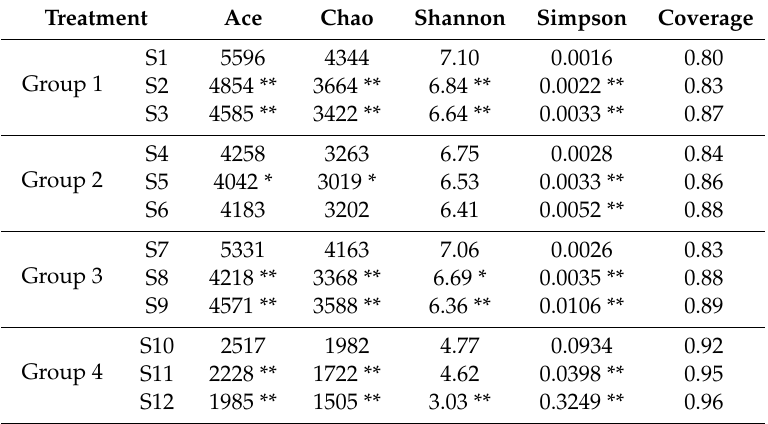
Table 2. Diversity indices and richness of bacteria in the di ff erent treatments.